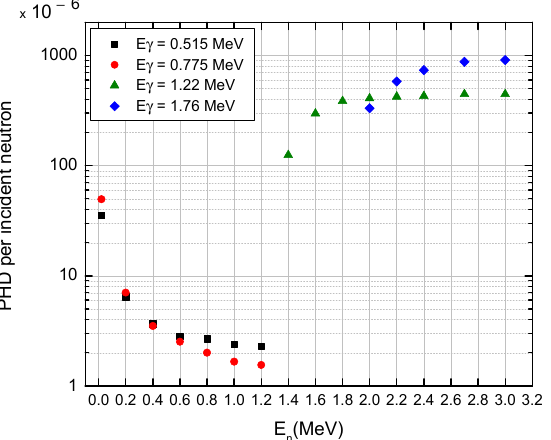
Figure 3. Summary of the intensity of the observed gamma radiation response (PHD per incident neutron) vs. neutron energy of KCl. Each color in the graph is the outcome of a different gamma energy line.